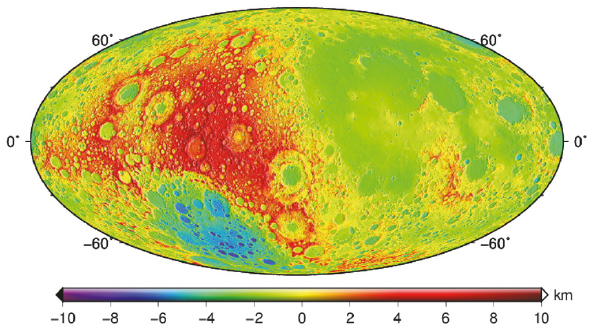
Figure 3: Lunar topography model based on the calibrated LAM data.